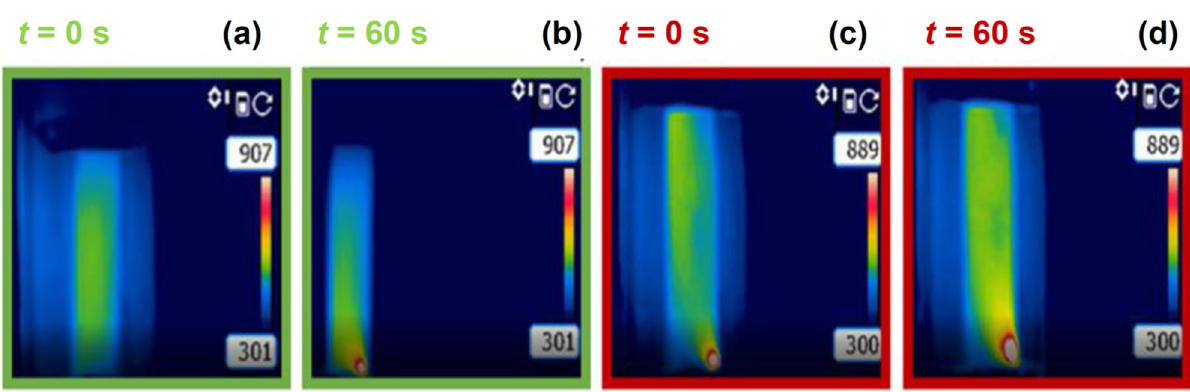
Figure 9. Temperature profile for the Ag-plated samples with four different applied current densities.